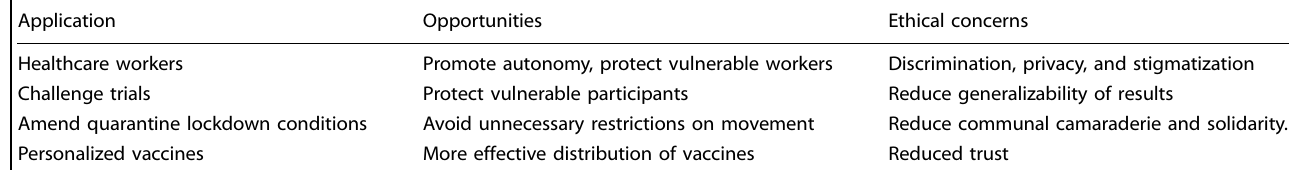
Table 1. Summary of the potential opportunities and concerns of potential COVID-19 host-genome testing